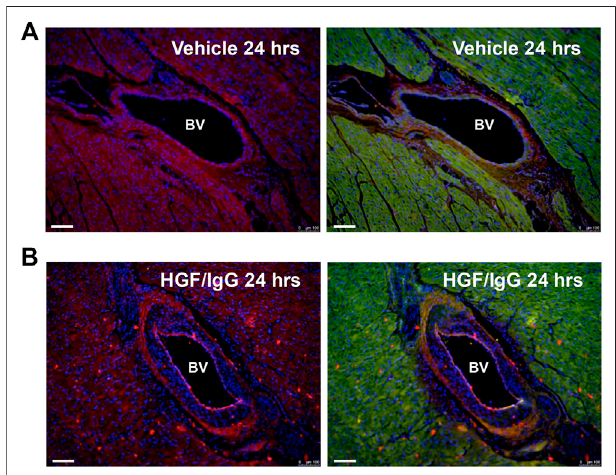
FIGURE2| Vascular andmyocardialdistribution ofHGF/IgGcomplexes 24 h after intracoronary infusion. Note red dots (ALEXA 594-conjugated secondary antibody) on endothelial wall and throughout myocardium in (B) that are not present in vehicle-treated heart (A) . Prior to staining with secondary antisera and DAPI (blue, nuclei), both (A) and (B) were stained with polyclonal primary antisera against 6x His-tag to detect recombinant human HGF.Heartsin (A) and (B) arerepresentativeofn=3pigspergroupthatwere